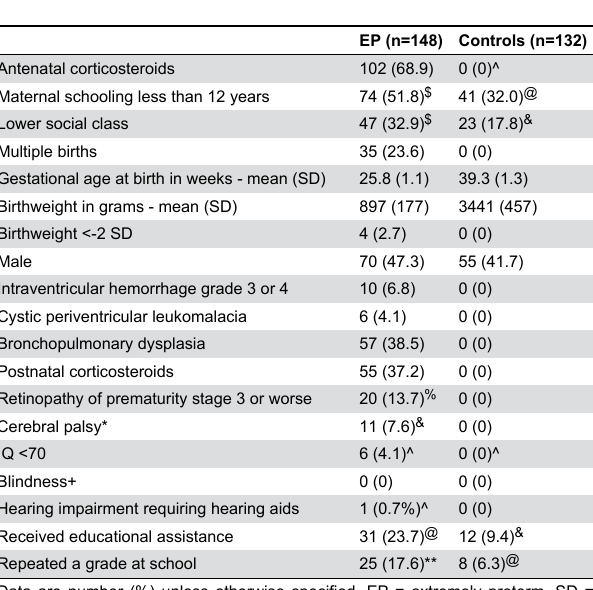
Table 1. Participant characteristics in EP adolescents compared with controls.